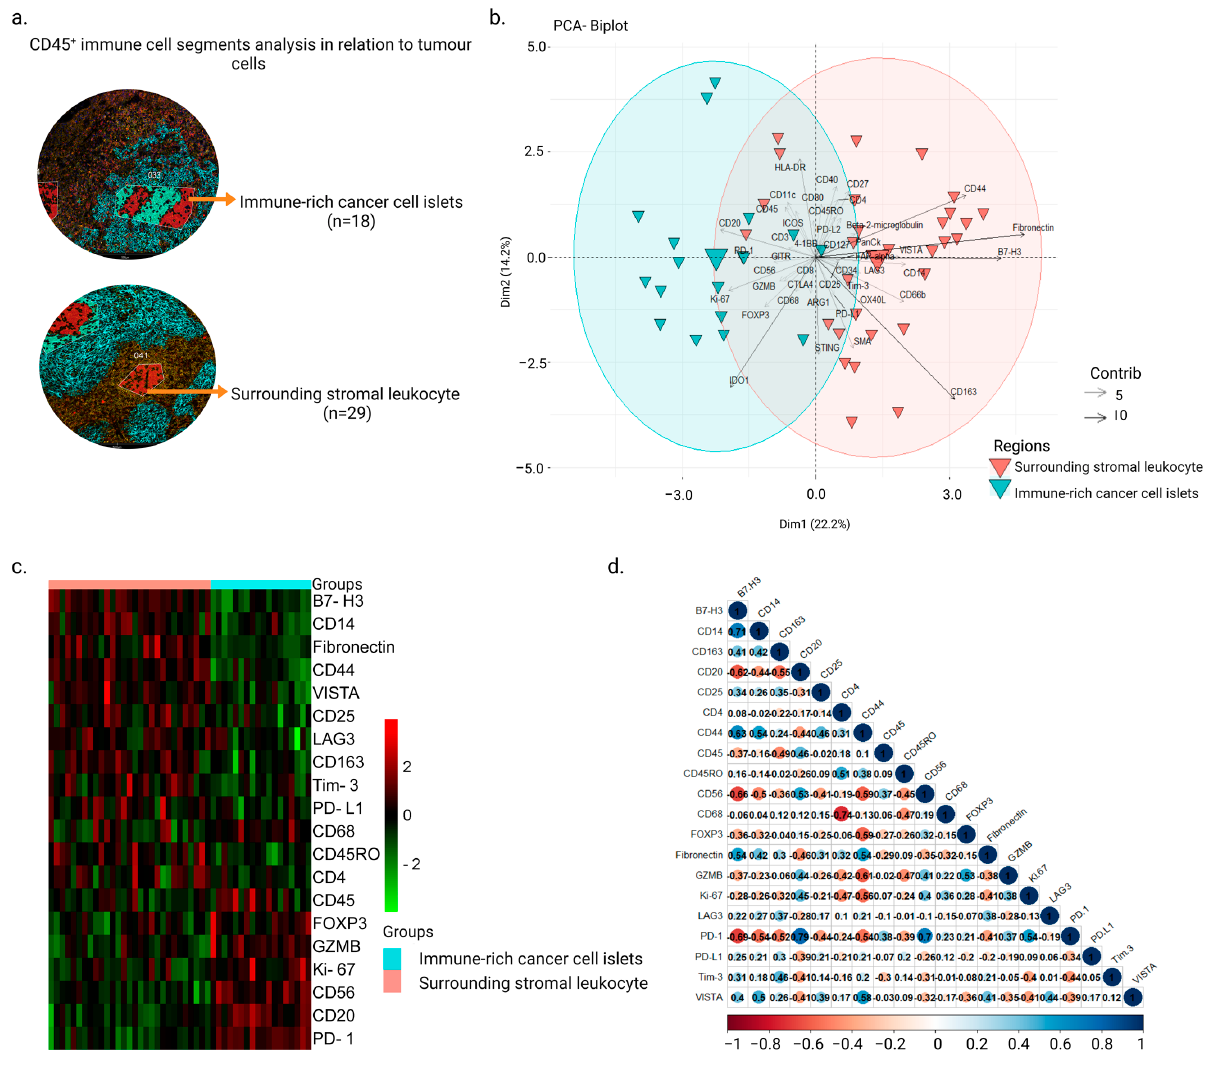
Figure 1. Differential expression profiles in CD45 + segments from ‘immune-rich cancer cell islets’ and ‘surrounding stromal leukocyte’ regions in NPC. ( a ) AOIs were generated based on cell expression of the morphological markers CD45 (red), PanCK (cyan), and CD8 (magenta) from the ROIs, and the collected oligonucleotides were quantified using the GeoMx ® DSP system. ( b ) Biplot principal component analysis showing ROI segments (AOIs) as well as protein markers on the first and second components from ‘immune-rich cancer cell islets’ and ‘surrounding stromal leukocyte’ regions. ( c ) Heatmap demonstrating DE proteins between ‘immune-rich cancer cell islets’ and ‘surrounding stromal leukocyte’ regions (Mann–Whitney test, p -value < 0.05). ( d ) Twenty DE proteins’ correlation map (Pearson’s correlation, signi fi cance taken at |r| > 0.7, p -value < 0.05).